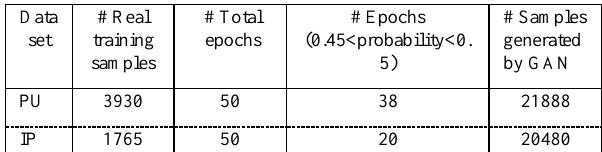
Table 1. Number of virtual training samples generation by GAN (PU: Pavia University, IP: Indian Pine)